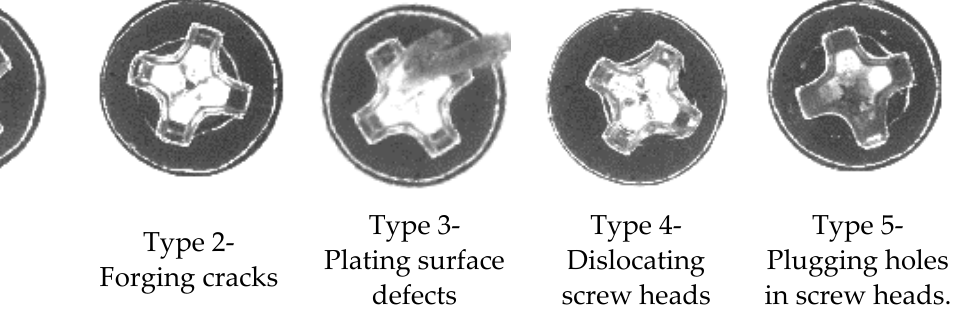
Figure 12. Instances of defective products.